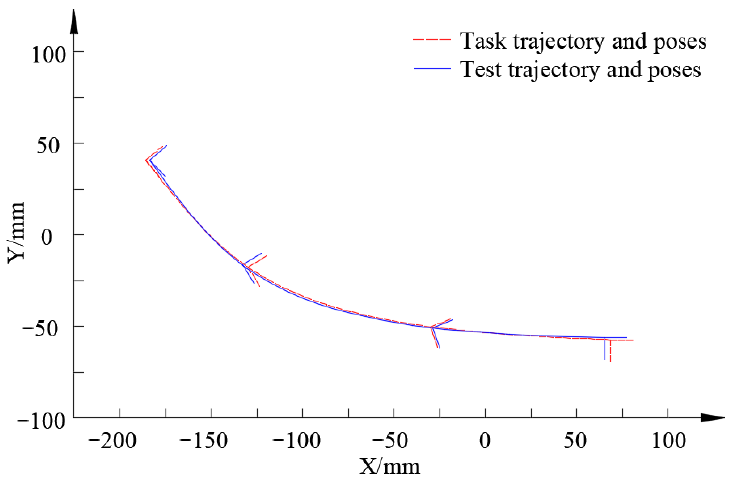
Figure 20. Comparison between test trajectory and poses and task trajectory and poses.